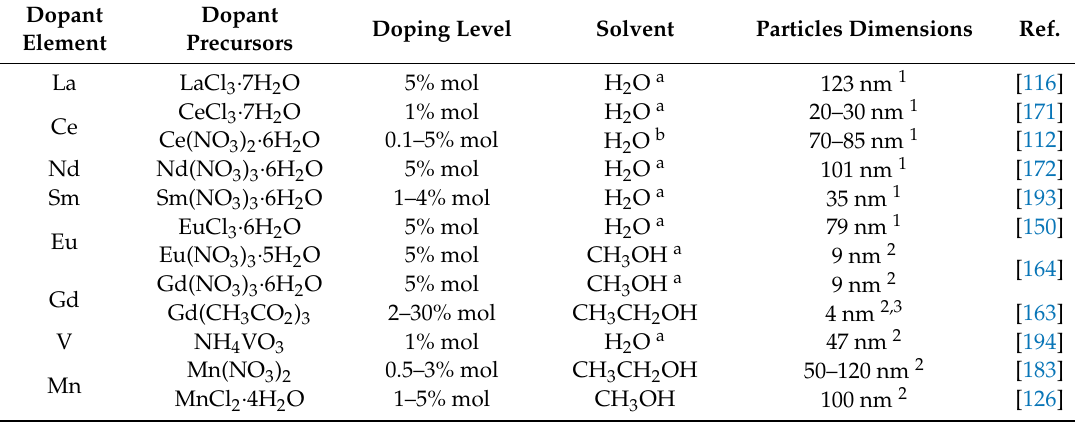
Table 2. Dopant ions and their respective precursors for the synthesis of ZnO nanoparticles by wet chemical